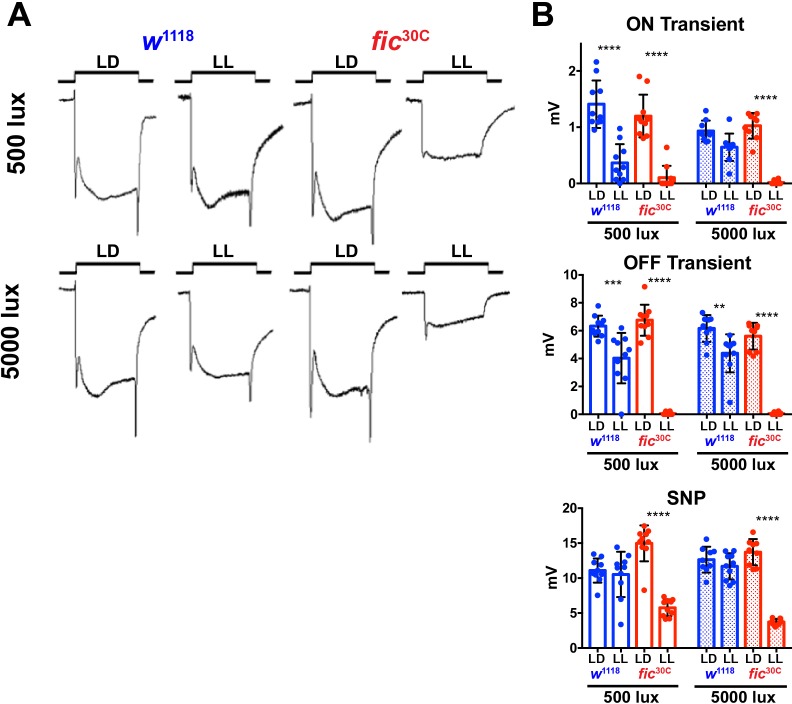
fic30C mutants are sensitive to constant light, regardless of total intensity.(A) Representative ERGs of flies following 3 days of LL or LD with either 500 or 5000 lux light, showing fic30C null animals lose ON/OFF transients and have reduced SNPs with constant light, regardless of intensity, but under LD conditions, even at 5000 lux, have healthy ERG responses. (B) Quantification of ERG data. Bar graphs show means ± SD. ****p<0.0001; ***p<0.001; *p<0.05; n = 10 flies per genotype and condition.10.7554/eLife.38752.017Figure 3—figure supplement 2—source data 2.Relates to Figure 3—figure supplement 2B.Quantification of ERG components with 500 and 5000 lux.